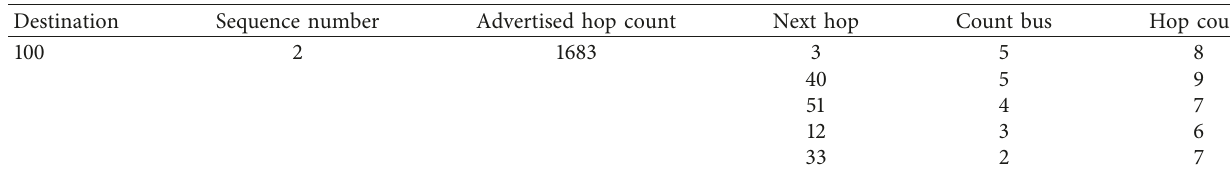
Table 4: Data from the route table of a node running